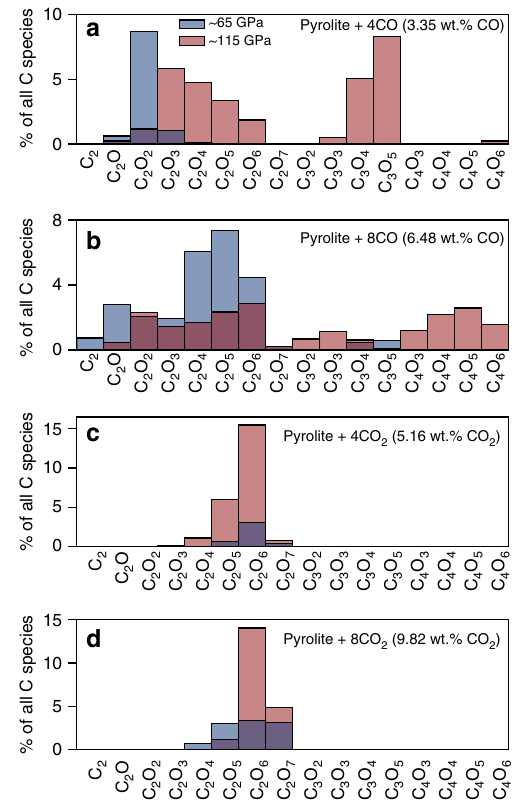
Fig. 2 Types of polymerized carbon species present in the pyrolitic melt at 4000 K. a Pyrolite + 4CO (3.35 wt% CO), ( b ) pyrolite + 8CO (6.48 wt% CO), ( c ) pyrolite + 4CO 2 (5.16 wt% CO 2 ), and ( d ) pyrolite + 8CO 2 (9.82 wt% CO 2 ) at average pressures of ~65 GPa (blue) and ~115 GPa (red). The y -axis is expressed as the percent of all carbon – oxygen species present in the melt, including unpolymerized carbon species. Please note the different y -axis scales